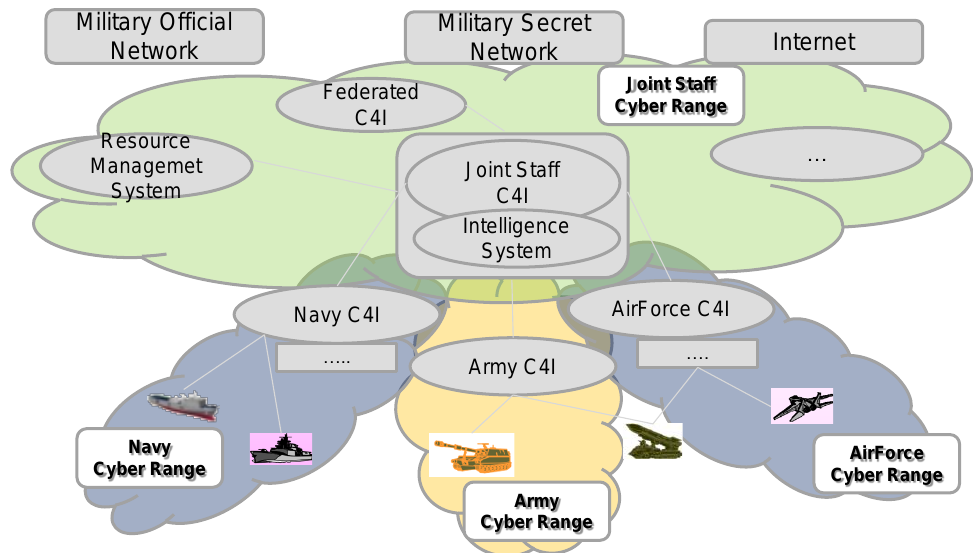
Figure 1. Operational architecture of theater level cyber range.